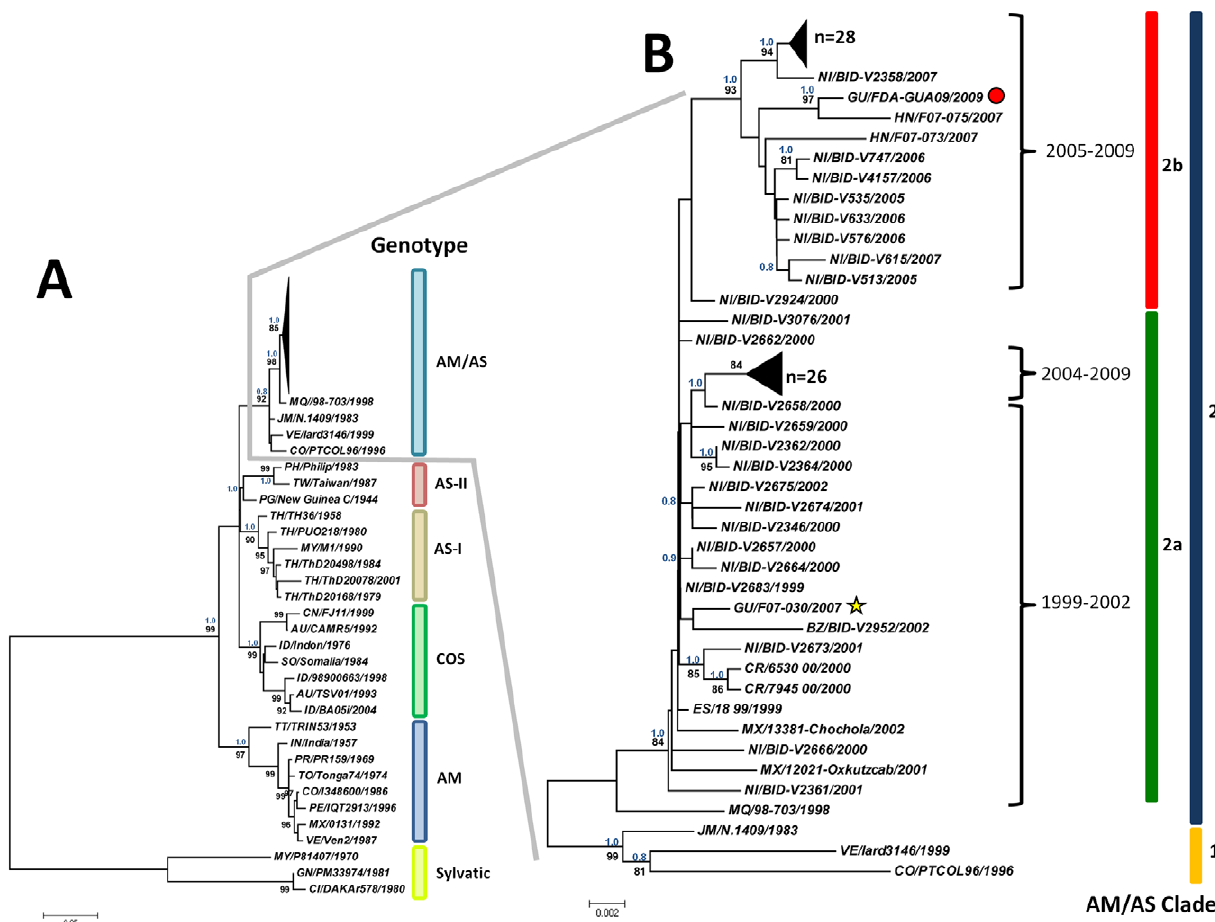
Figure 2. Maximum Likelihood (ML) consensus tree of the Envelope protein gene of DENV-2. A) The phylogenetic relationships between members of all DENV-2 genotypes based on the sequences of the Envelope protein gene. DENV-2 genotypes (Sylvatic, American, Asian I and II, Cosmopolitan and American/Asian) are identified. B) ML tree showing in details the relationships between Central American and Mexican isolates collected between 1999 and 2009. Similar sequences at the top of clades 2a and 2b are shown collapsed. A red circle and a yellow star denote strains GU/FDA-GUA09/2009 and GU/F07-030/2007, respectively. Consensus trees were generated by ML and Bayesian methods. Bootstrap support values of 1,000 replicates using the ML model of evolution and Bayesian posterior probability values are shown above and below each node. Only bootstrapping values . 80 are shown. Branch lengths are proportional to the bar and represent the number of nucleotide substitutions between the analyzed